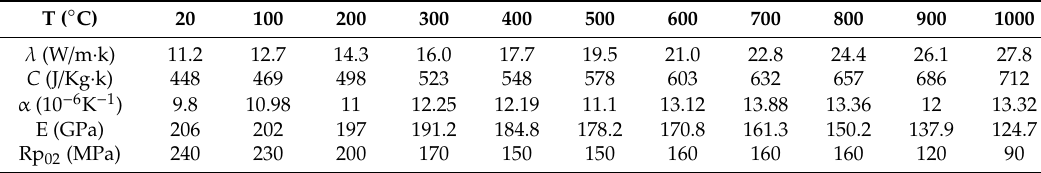
Table 3. Physical properties of Inconel 601 [9].